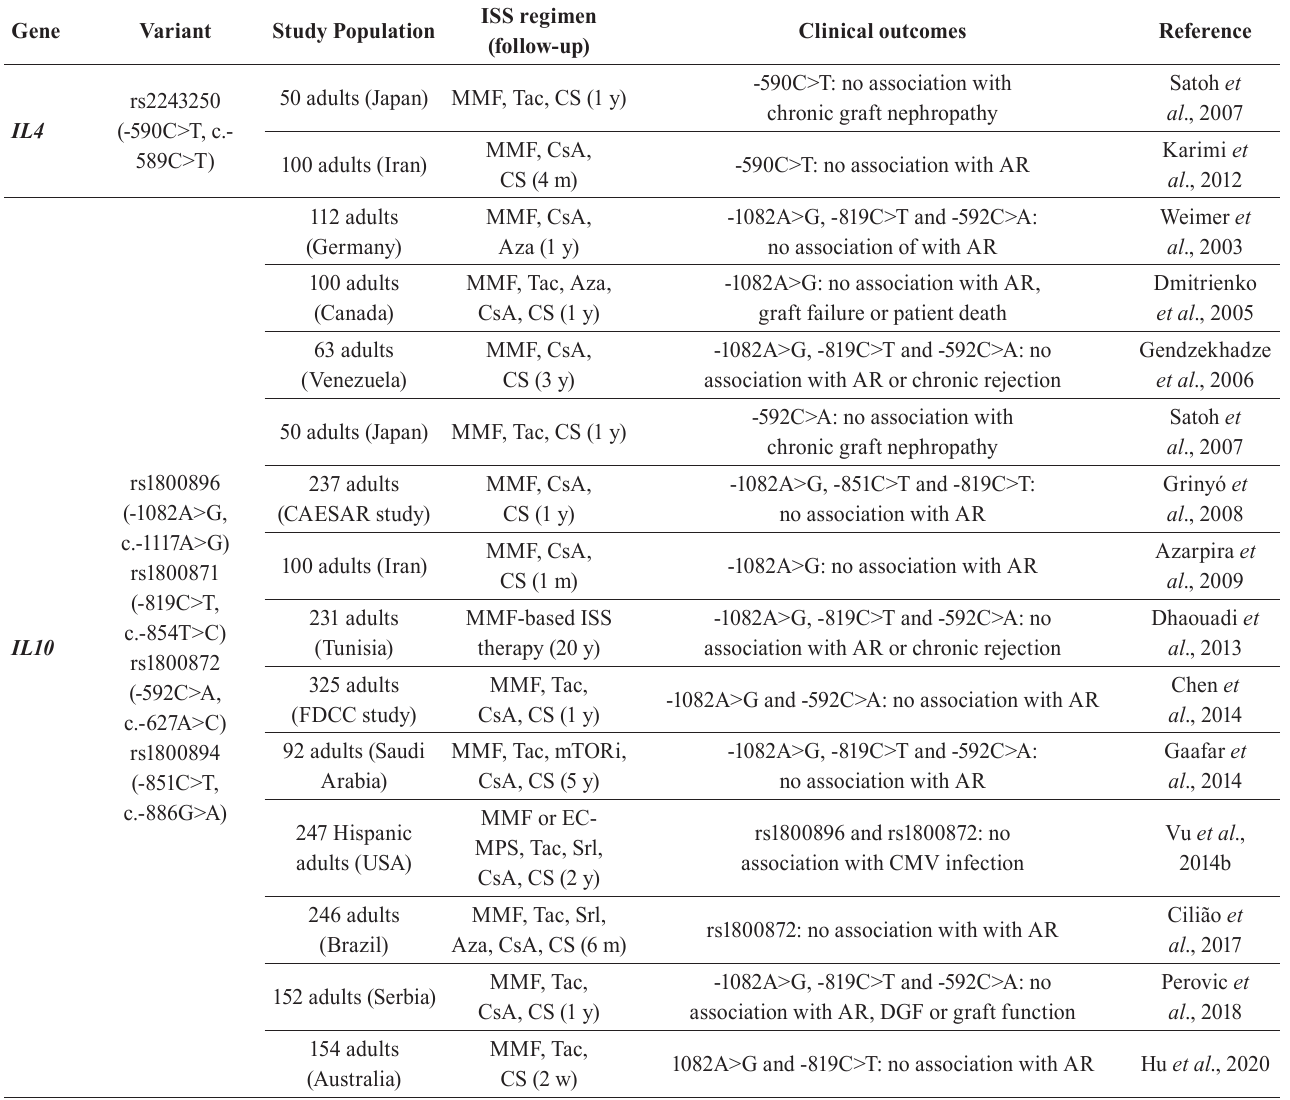
TABLE V - G enes relat ed to immunomodulatory cytokines in kidney recipients on MPA therapy without significant associations Gene Variant Study Population